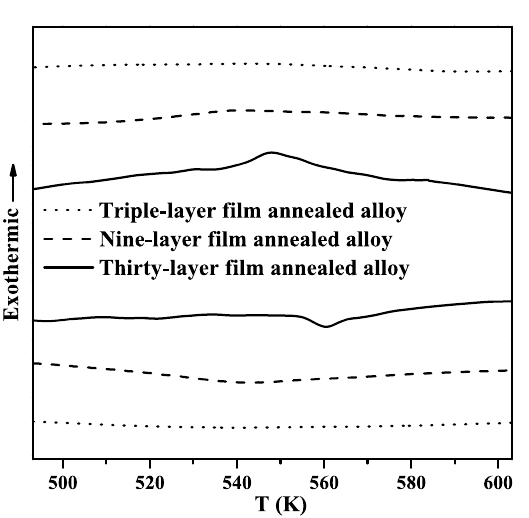
Figure 6. SEM images of surface and images and EDS mapping of cross-sections of ( a ) the ( n = 1) film and ( b ) ( n = 3) film after annealing 1273 K, 1.5 hours.